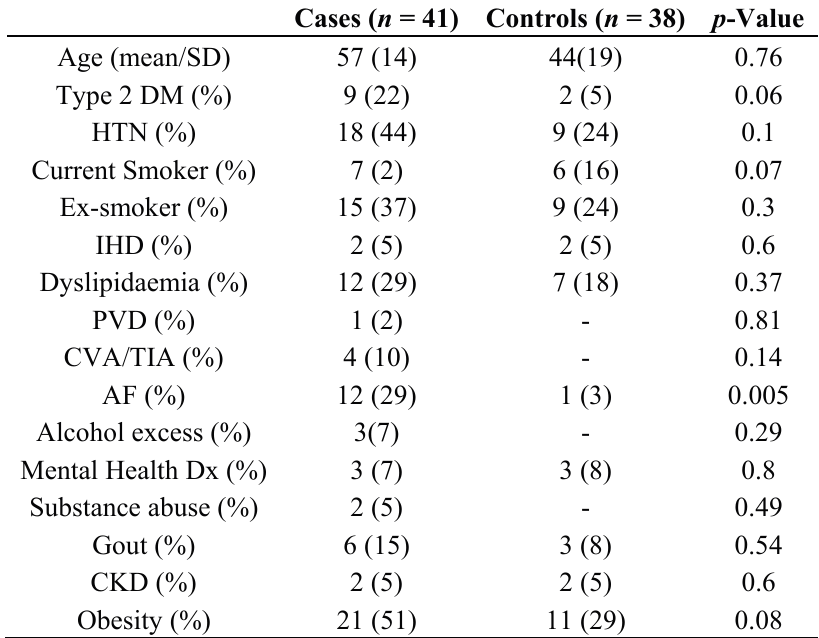
Table 1. Patient